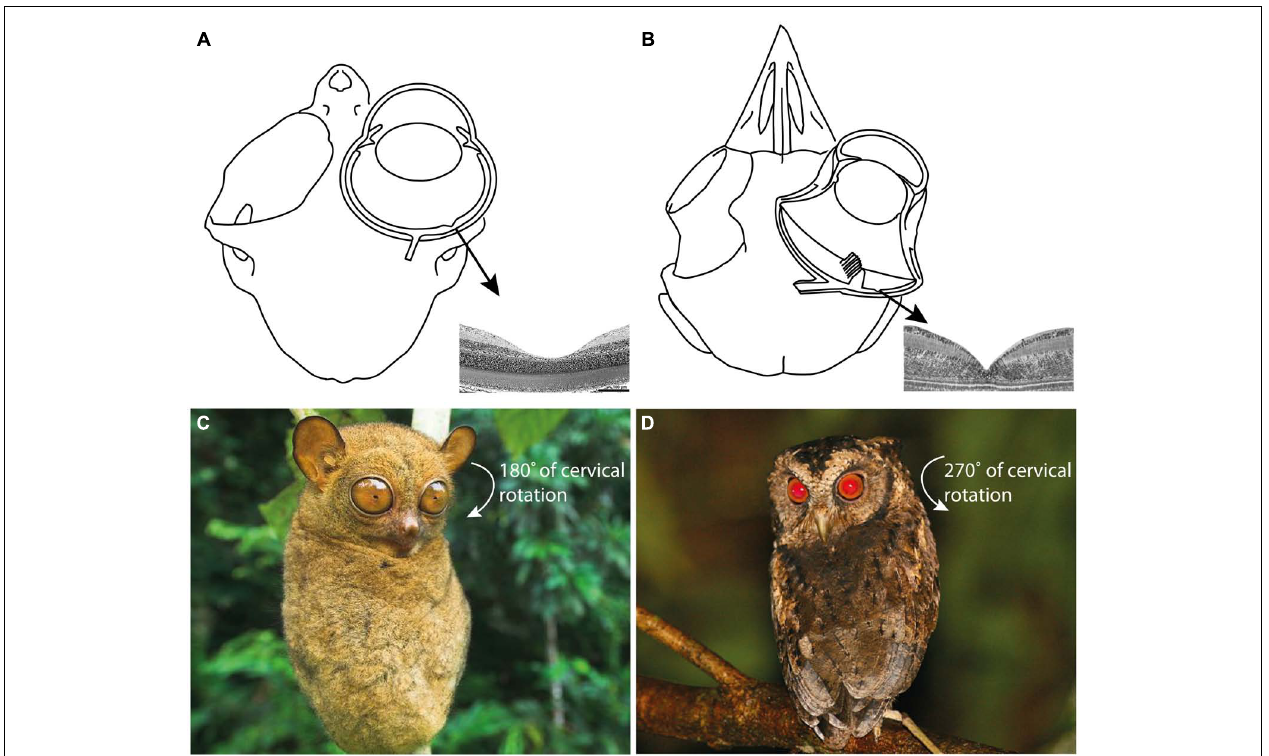
FIGURE 3 | (A) The skull and eye of Tarsius bancanus (modified from Castenholz, 1984; Ross, 2004) together with the fovea of T. spectrum (modified from Hendrickson etal., 2000). (B) The skull, eye, and fovea of a composite strigiform (modified from Fite, 1973; Menegaz and Kirk, 2009). Because ocular mobility is constrained by the hyperenlarged eyes of tarsiers and scops owls, an extraordinary degree of cervical rotation is necessary to enable rapid prey localization and fixation. (C) The